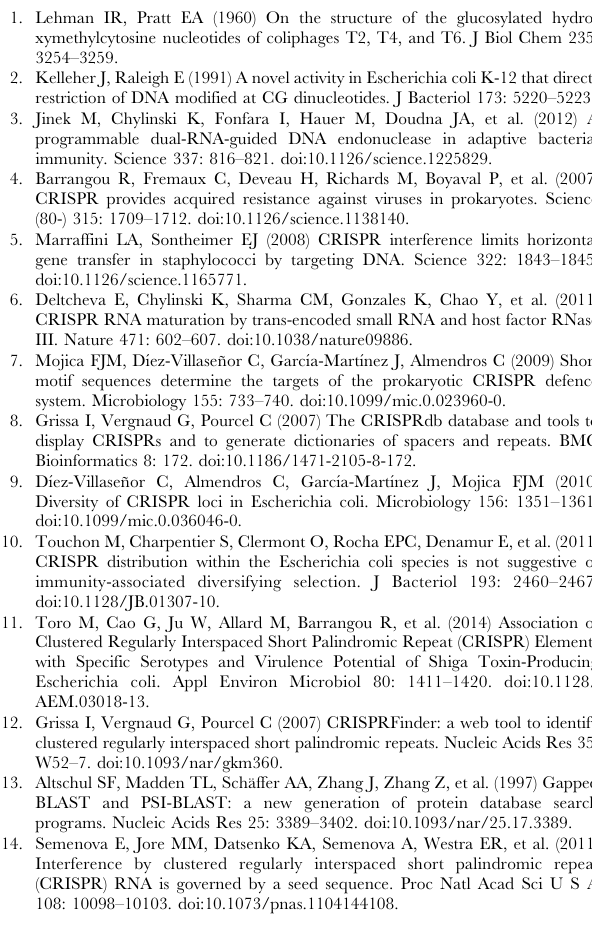
denotes cutting. (TIF) Figure S2 Efficiency of plating of T4 gt on wild-type E. coli K-12. Calculated relative to either T4 infecting E. coli K-12 or T4 gt infecting restriction-less E. coli K-12, phage T4 gt forms plaques on E. coli K-12 at four orders of magnitude less efficiently (red data points). As a general comparison of restriction- modification versus Cas9-mediated protection, Cas9 provides around an order of magnitude greater resistance to phage infection on average, though the level of resistance varies by sequence (blue data points). Independent replicates (n= 11, 5, 5, 5, 4, 15) are plotted; lines represent the median. Cas9 + data were compiled from experiments with various spacer sequences as described in the main text. (TIF) Table S1 Phage escapee analysis. We picked 13 plaques that formed on Cas9-protected host E. coli strains and sequenced the targeted region to identify any mutations. The PAM sequences are underlined. Mutations are in bold text and double-underlined.